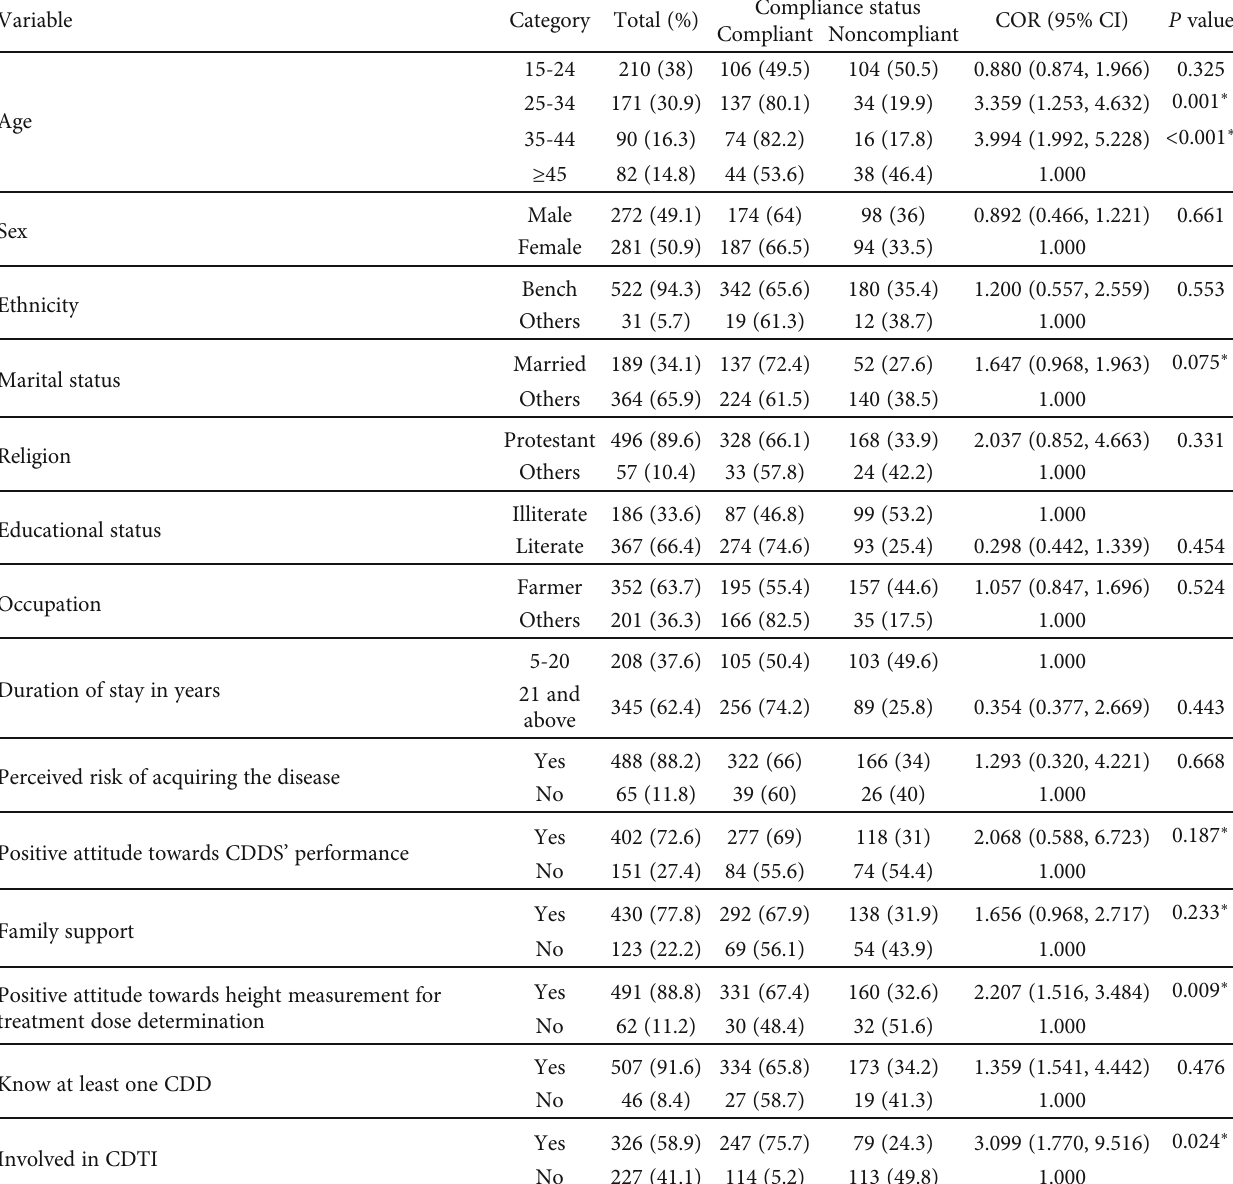
Table 4: Results of the bivariate analysis of predictors of compliance with ivermectin treatment in the Semen Bench District, Bench Maji Zone, Southwest Ethiopia, June 2018 ð n = 553 Þ